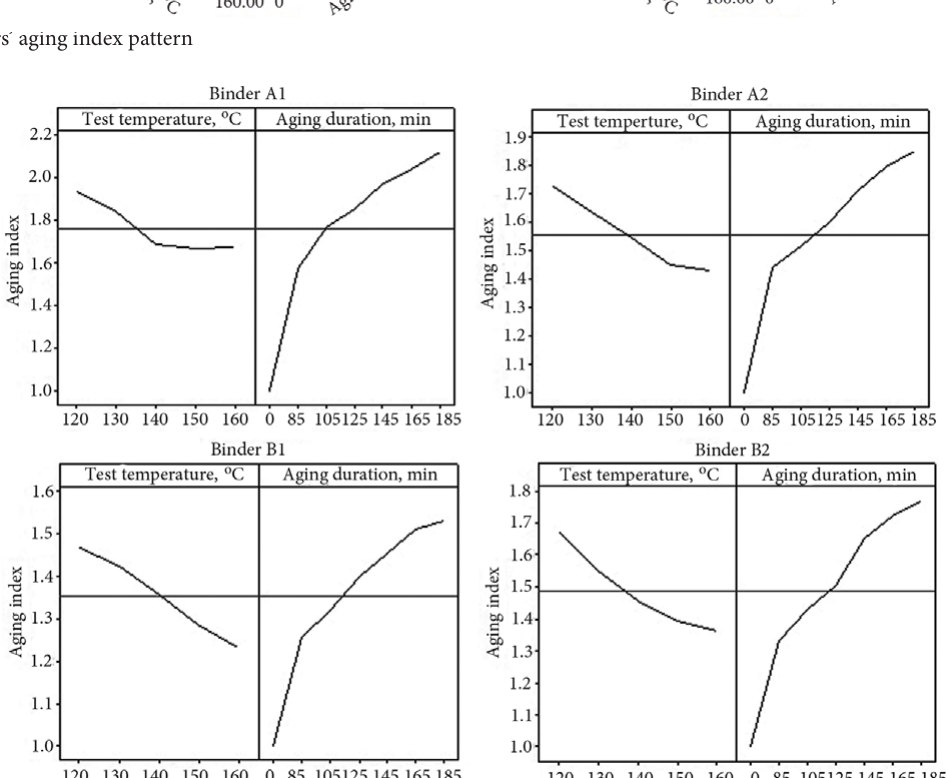
Fig. 3. Binders’ aging index pattern